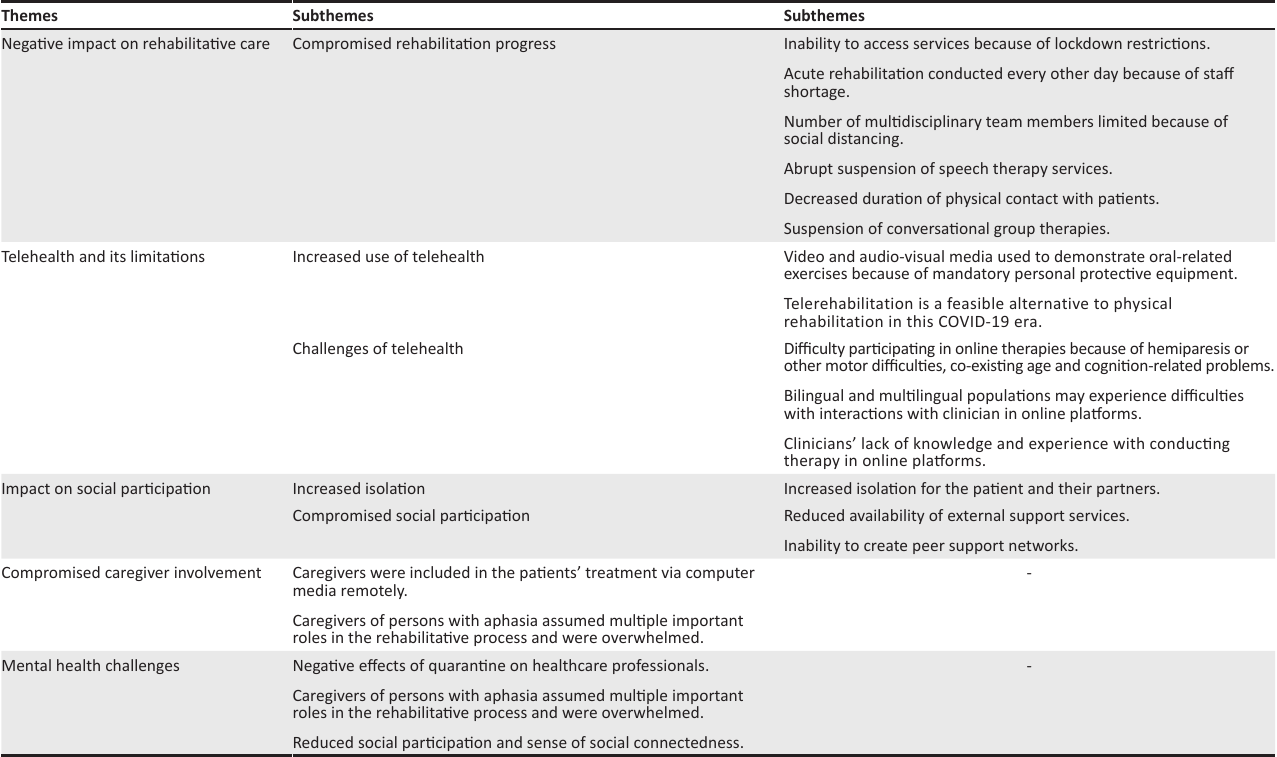
TABLE 3: Themes and subthemes that emerged from an analysis of the studies included in the review.